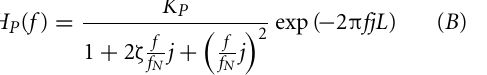
Frontiers in Physiology | Integrative